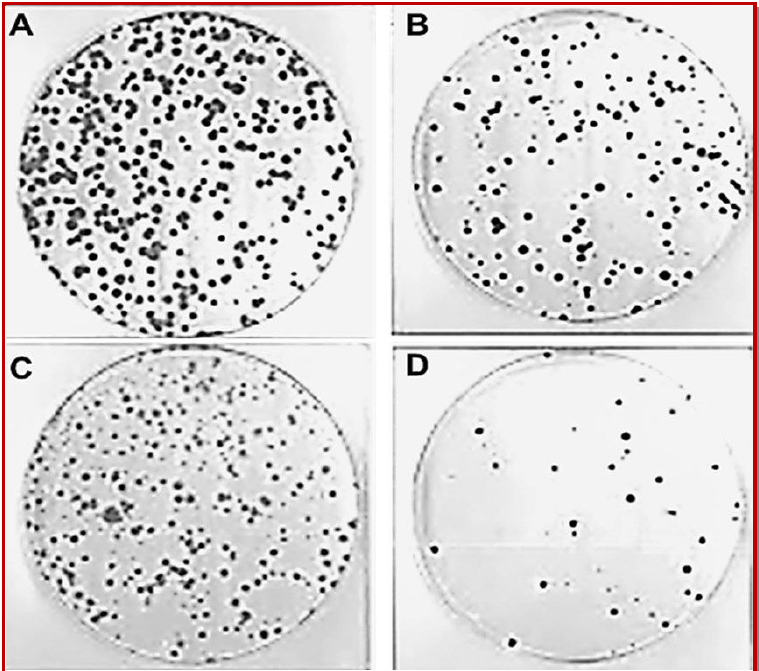
Figure 4: Effect of triazolyl derivative of beta-bisabolol on colony formation potential in ME-180 cervical cancer cells. The cells were treated with 0 µM (A), 9 µM (B), 36 µM (C) and 72 µM (D) dose of TTB respectively A B